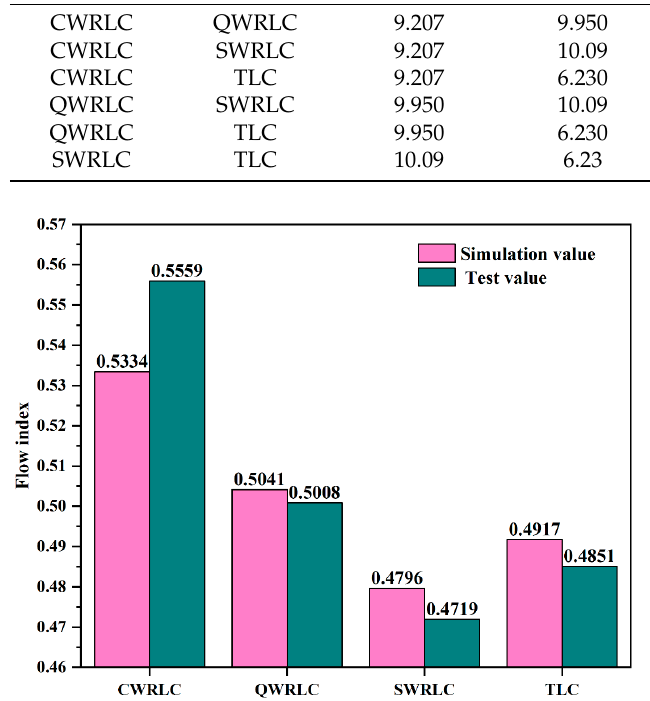
Table 4. Statistical analysis of the differences of the emitter flow rate using Tukey’s method at 200 KPa.